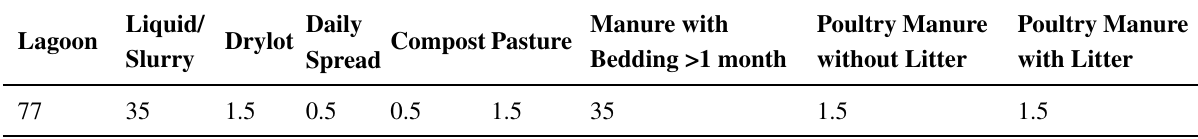
Table 3. Intergovernmental Panel on Climate Change (IPCC) 2006 default methane conversion factors for different manure management systems.